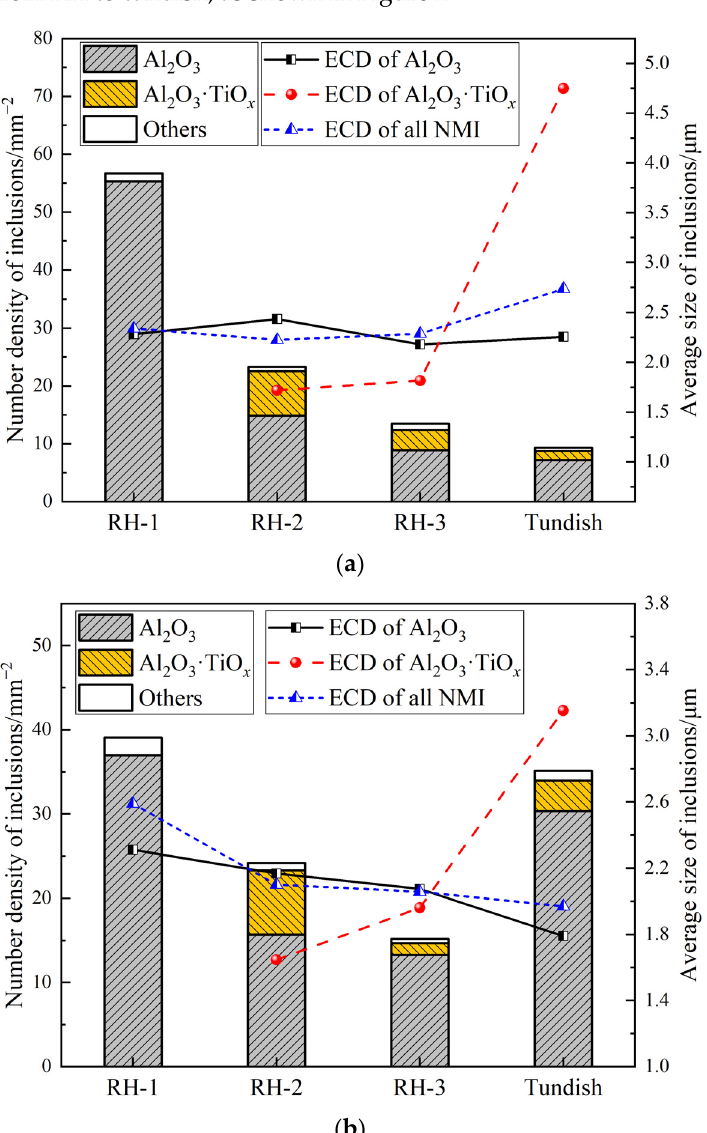
Figure 2. Number and size of different inclusions in ( a ) Heat 1 and ( b ) Heat 2 during RH treatment and tundish